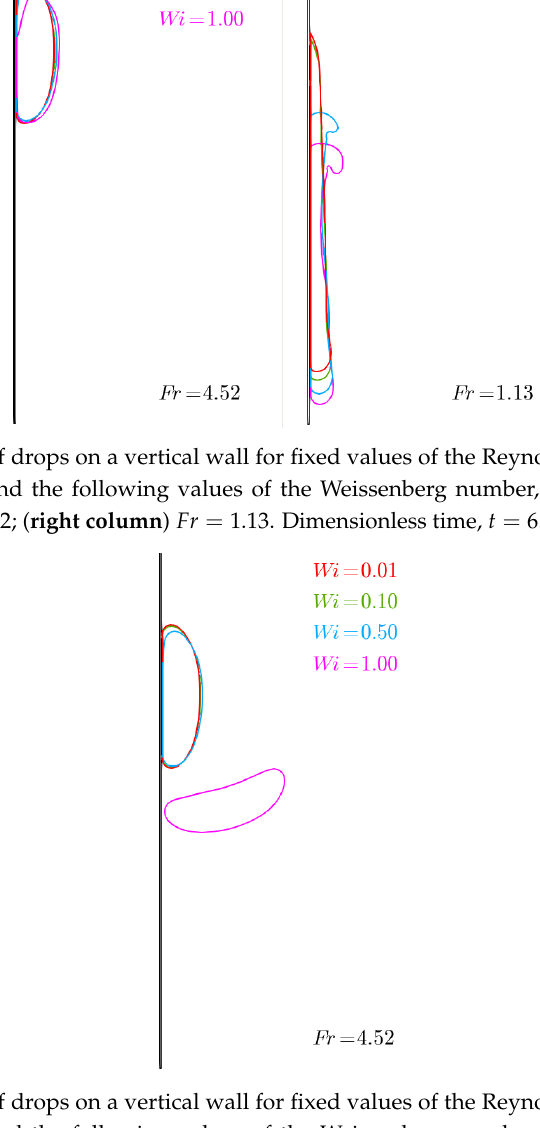
Figure 11. Collision of drops on a vertical wall for fixed values of the Reynolds, Re = 8, and plastic numbers, τ y = 0.4 and the following values of the Weissenberg number, Wi = { 0.01;0.1;0.5;1 } . ( left column ) Fr = 4.52; ( right column ) Fr = 1.13. Dimensionless time, t =